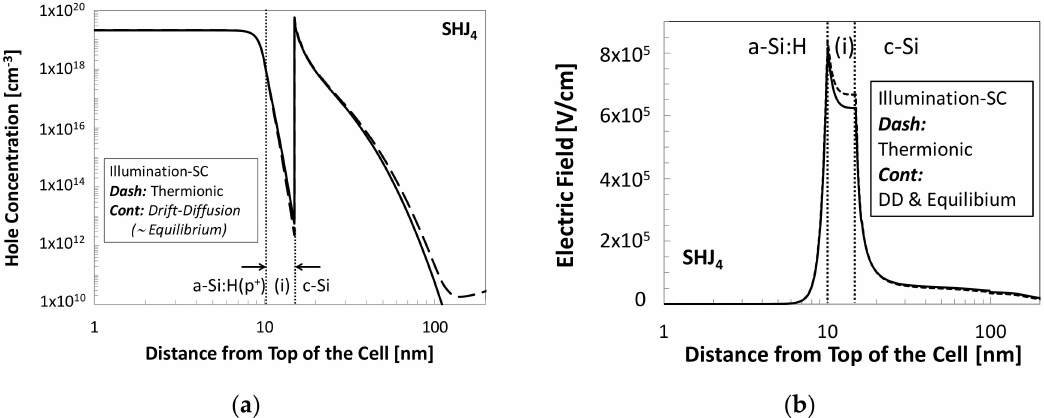
Figure 12. Simulated ( a ) free hole concentration profile and ( b ) electric Field distribution at equilibrium (Cont. line) and under illumination-SC ( Dash ) for cell SHJ 4 assuming thermionic emission hole transport at the hetero-interface with a default value of A * .